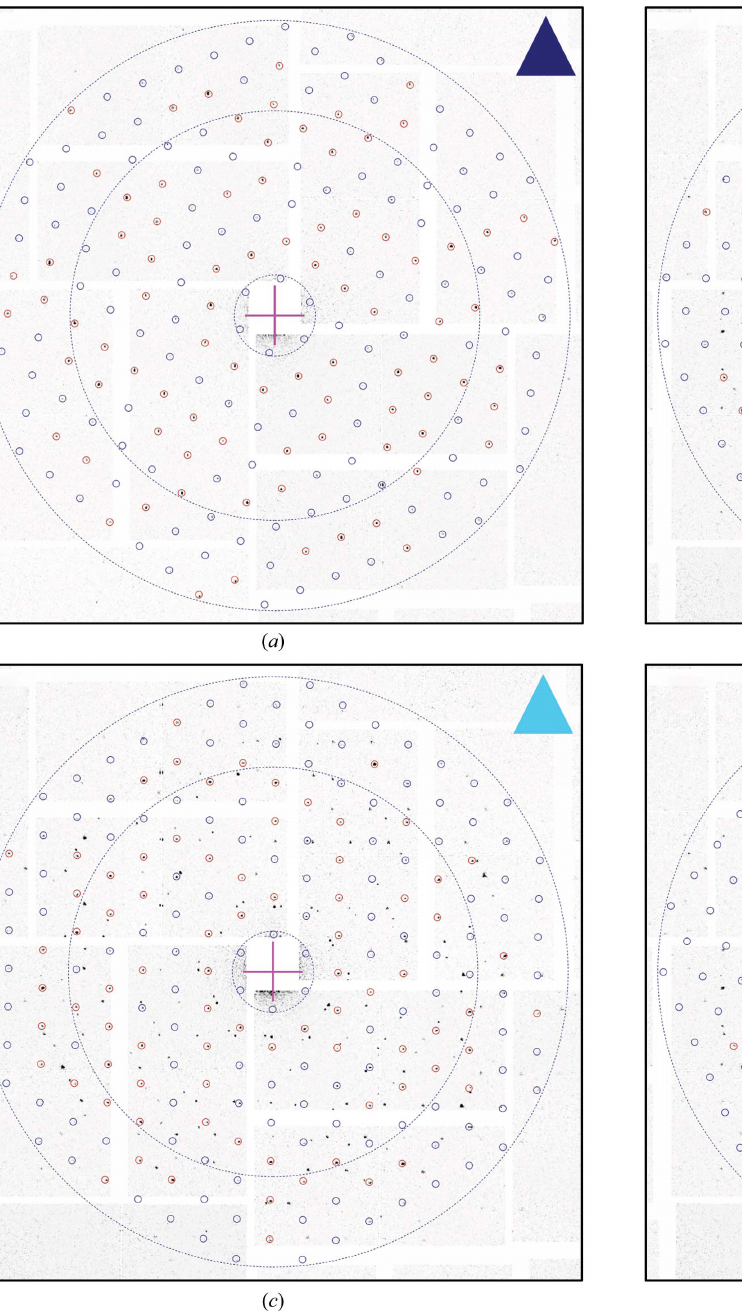
Figure 4 Lattice patterns. The four plots show examples of lattices obtained after step 2 of the data-analysis procedure, and are represented as circles that mark the expected peak positions down to an in-plane resolution of 7 A˚ , superimposed on the corresponding diffraction image. Red circles indicate the more prominent peaks that were identified and used to establish the precise lattice orientation and its unit-cell size. ( a ) is the single lattice image of Fig. 3( a ) (violet triangle label). ( b ), ( c ) and ( d ) are the same multiple lattice image of Fig. 3( b ) (cyan triangle label), from which three different lattices were identified. The dashed blue rings correspond to 50, 10 and 7.0 A˚ in-plane resolution. The magenta cross represents the direct-beam